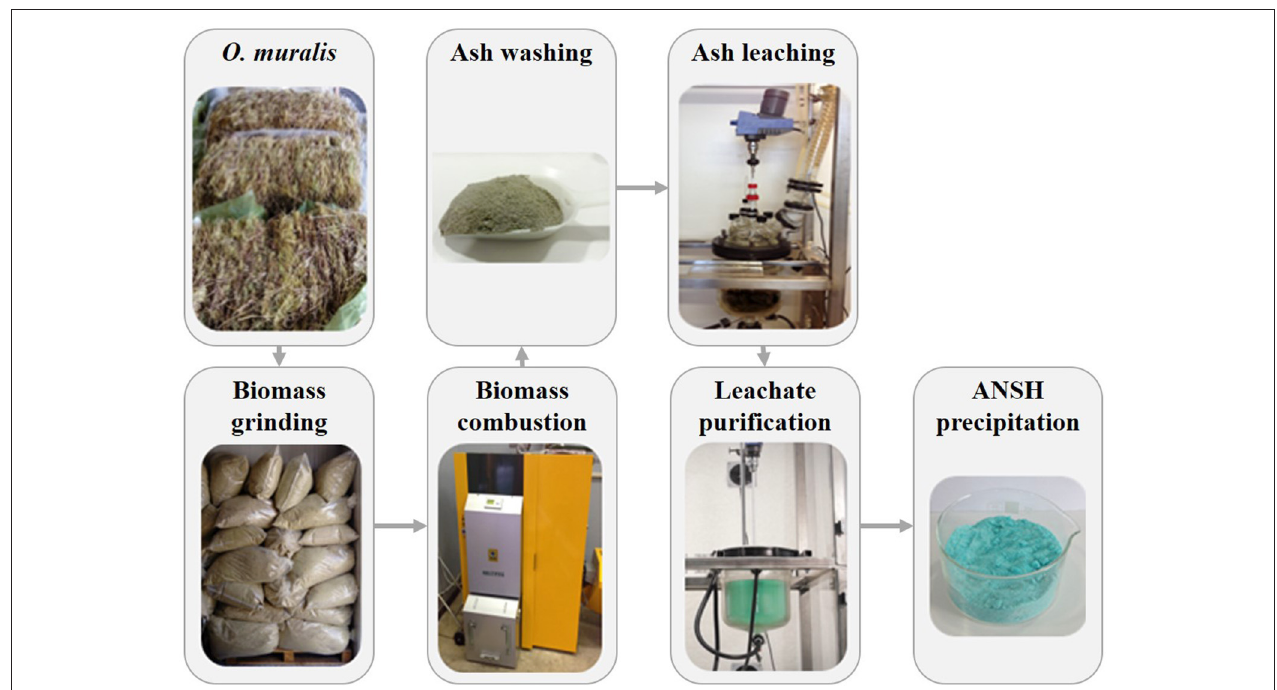
FIGURE 6 | Process description for the preparation of ANSH from Odontarrhena muralis s.l. at the pilot